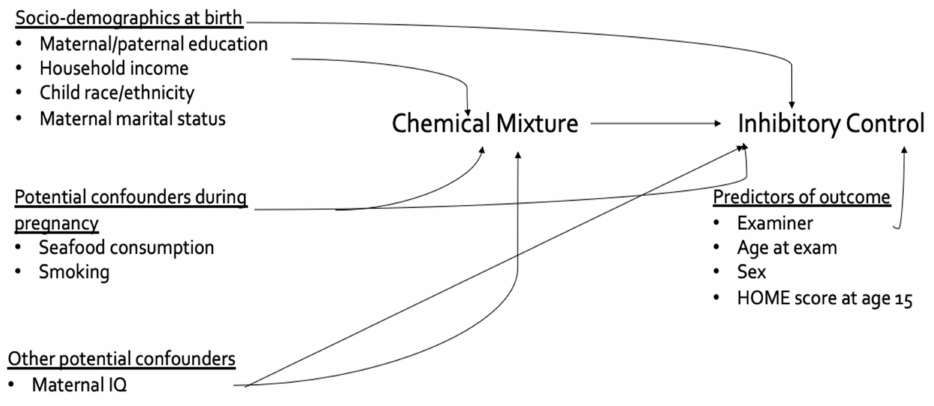
Figure 1. Directed acyclic graph (DAG) describing potential confounders and predictors of inhibition that were included in adjusted models. The underlined portion describes the different categories of covariates included in this model.